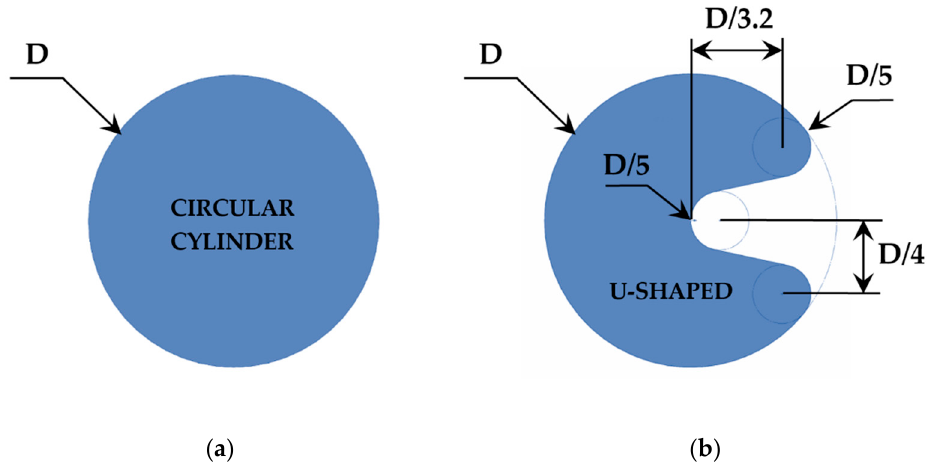
Figure 2. Sectional representation of the oscillating body: ( a ) circular cylinder and ( b ) U-shaped geometry.